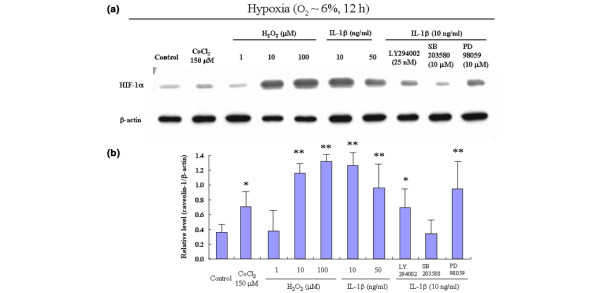
Catabolic factors induce the expression of HIF-1α protein in human articular cartilage. (a)Hypoxia-inducible factor 1α (HIF-1α) protein was accelerated by IL-1β or H2O2in cultured chondrocytes under hypoxic conditions. (b)Under hypoxic conditions, the inhibitors of PI3K and p38 mitogen-activated protein kinase (MAPK) reduced protein levels of IL-1β-induced HIF-1α expression. Cobalt chloride (CoCl2), chemical inducer of HIF-1, was used for the positive control. *P < 0.05, **P < 0.01 compared with the control. LY294002: phosphatidylinositol 3-kinase inhibitor; SB203580: p38 mitogen-activated protein kinase inhibitor; PD98059: extracellular signal-regulated kinase inhibitor.